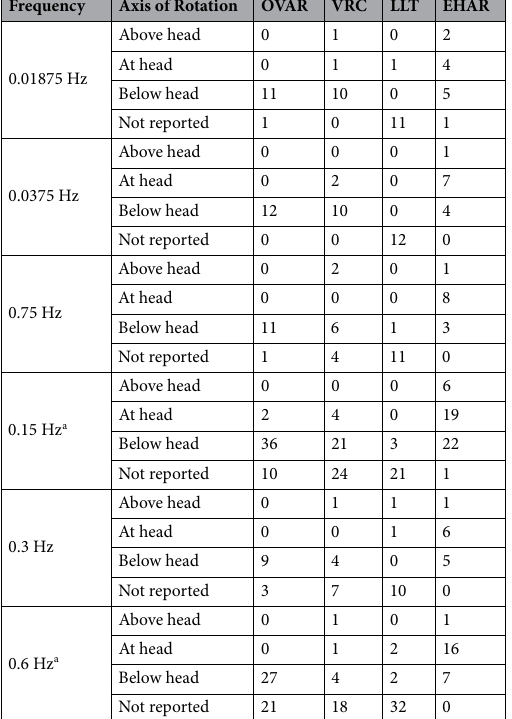
Table 4. Number of times subjects perceived body tilt with the axis of rotation above, at, or below their head for each frequency during the various motion paradigms. a Frequency includes all tilt angles tested (see Table